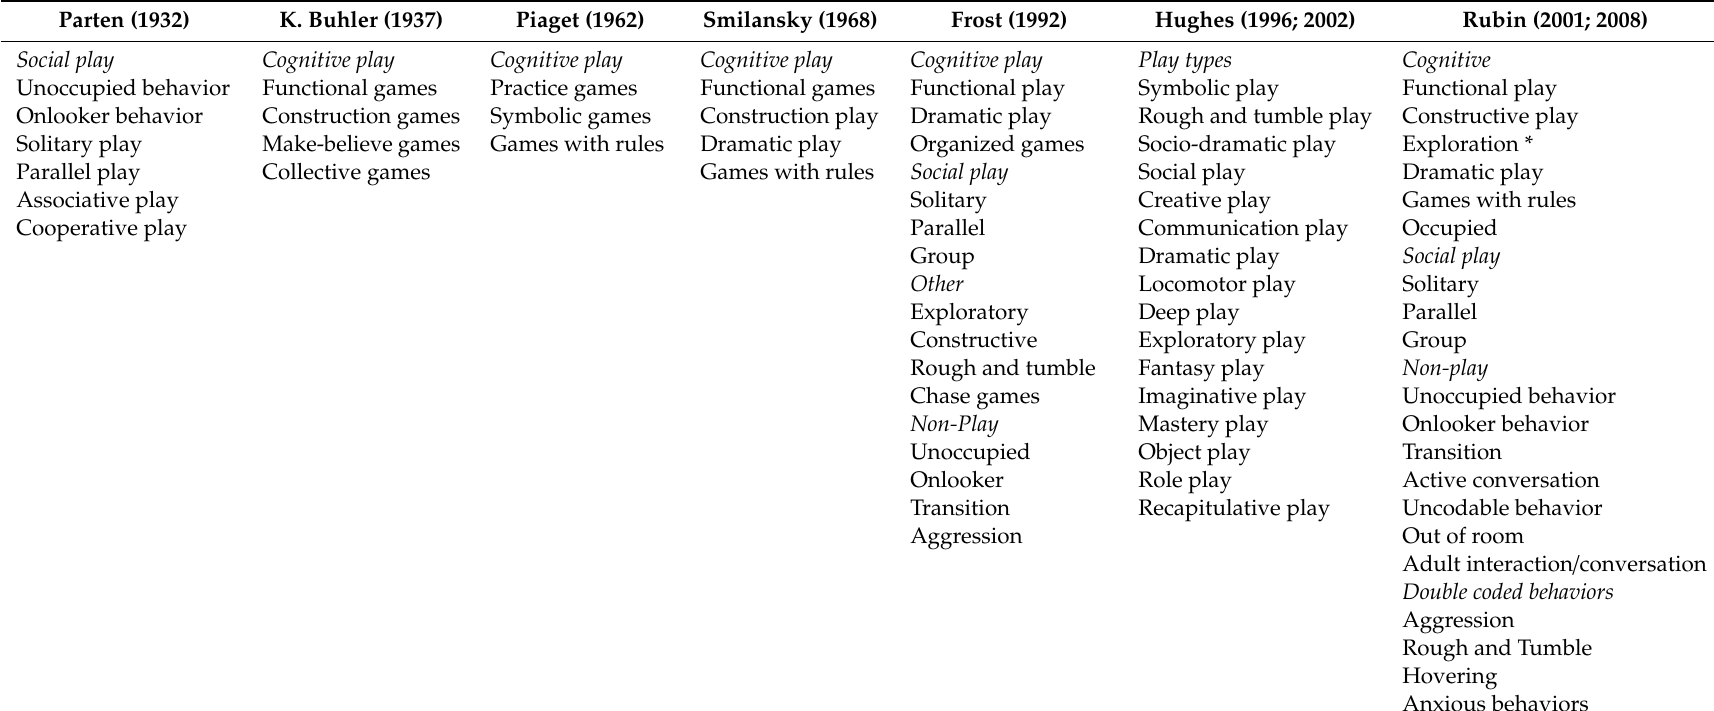
Table 1. Play typology